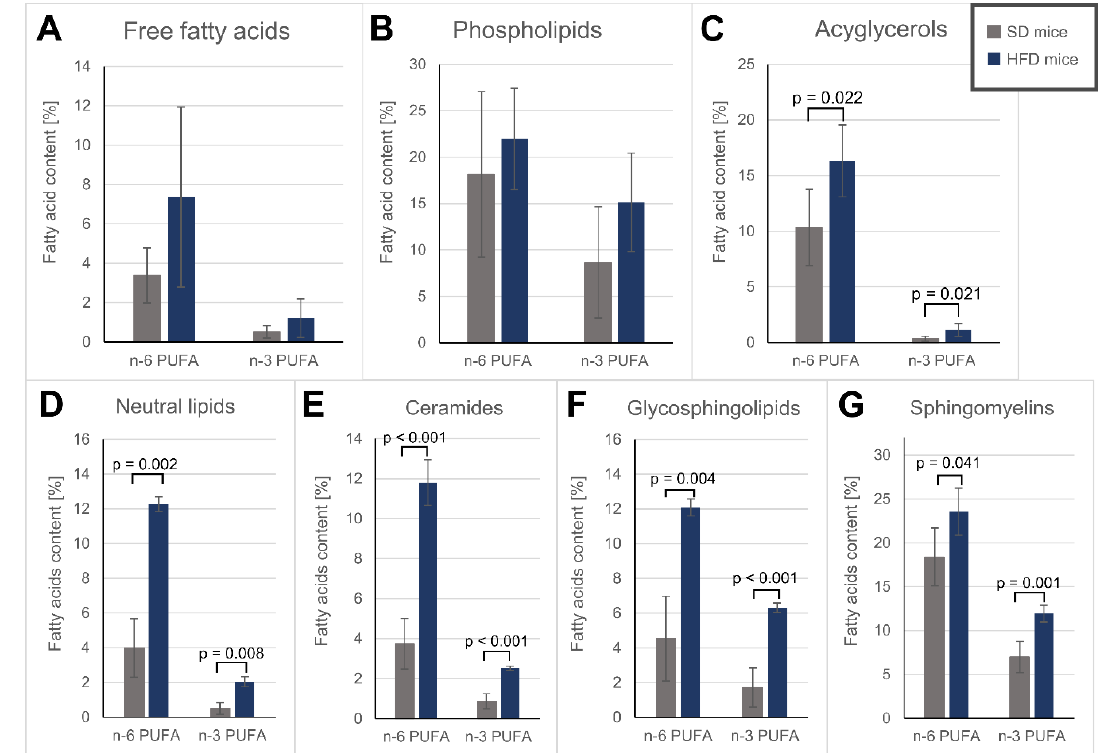
Figure 2. n -6 and n -3 polyunsaturated fatty acids content in different lipids fractions: ( A ) – free fatty acids; ( B ) – phospholipids; ( C ) – acylglycerols; ( D ) – neutral lipids; ( E ) – ceramides; ( F ) – glycosphingolipids; ( G ) - sphingomyelins; SD – mice fed standard diet; HFD – mice fed high fat diet.